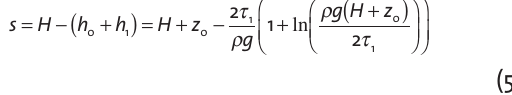
Figure 1 (left above): View of the modified slump test: a) with the outer cylinder, before material release, b) after material release. Figure 2 (left below): Detailed scheme of our modified slump